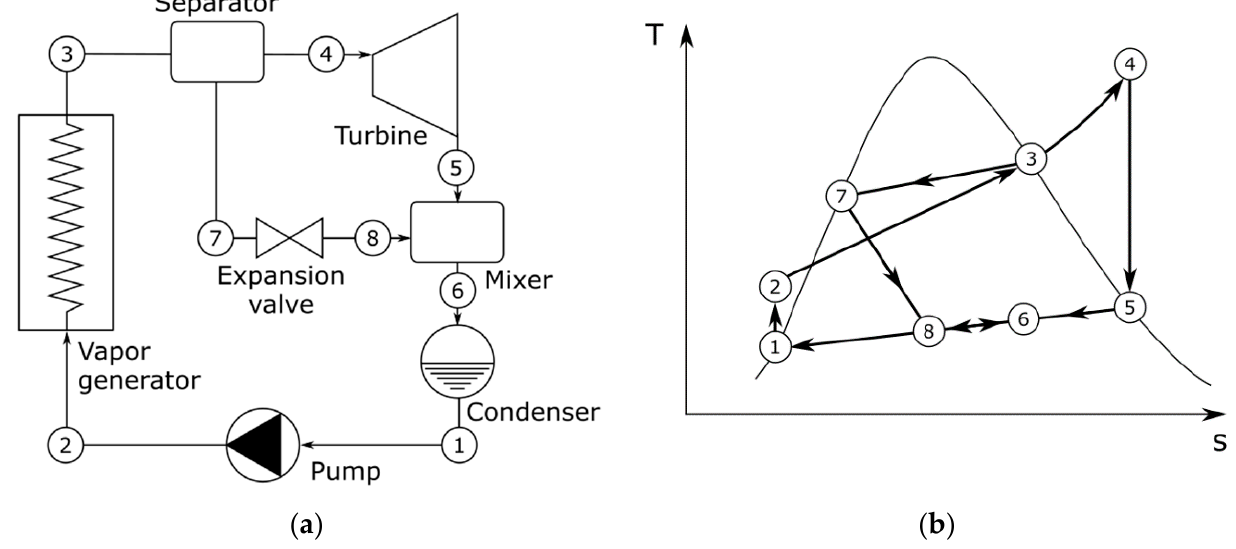
Figure 19. ( a ) Equipment and ( b ) T-s diagram of an ideal Kalina cycle.